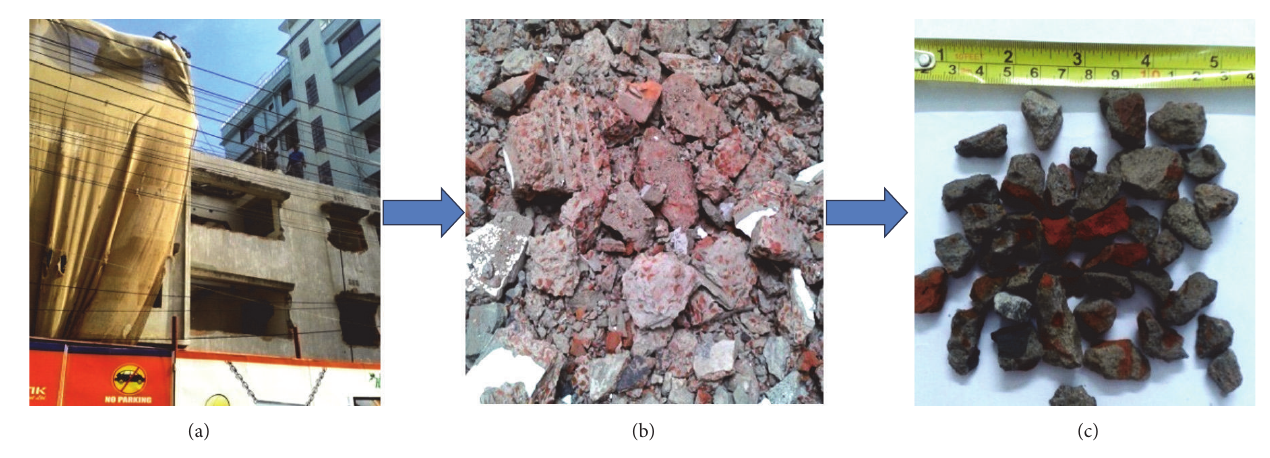
Figure 1: (a) Demolished building, (b) block, and (c) recycled brick aggregate.